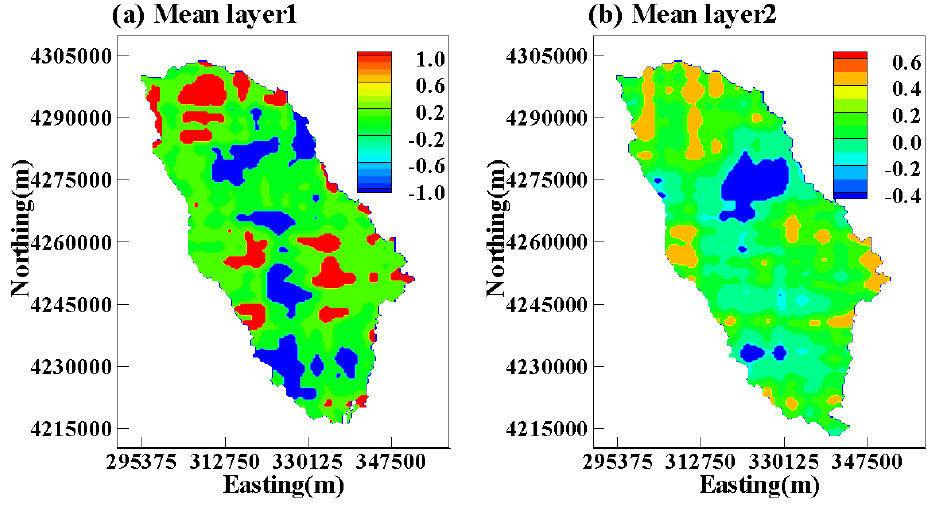
Figure 8. The multi-model ensemble mean and variance of log hydraulic conductivity for each layer before data